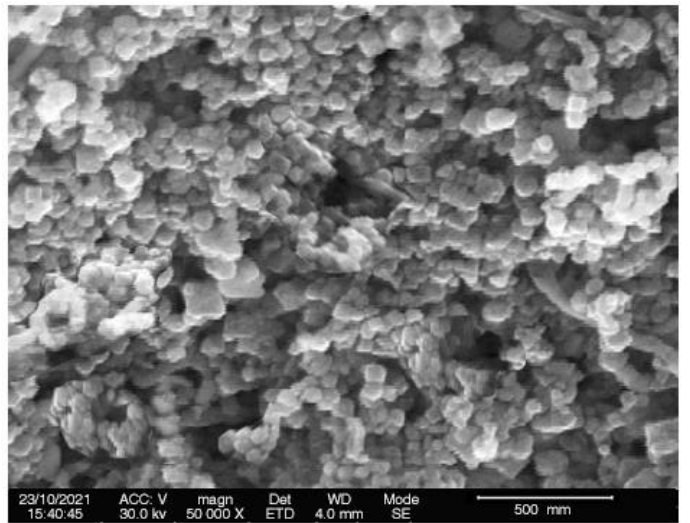
Figure 4. Scanning electron microscopic analysis of the TA-mediated CuNPs.